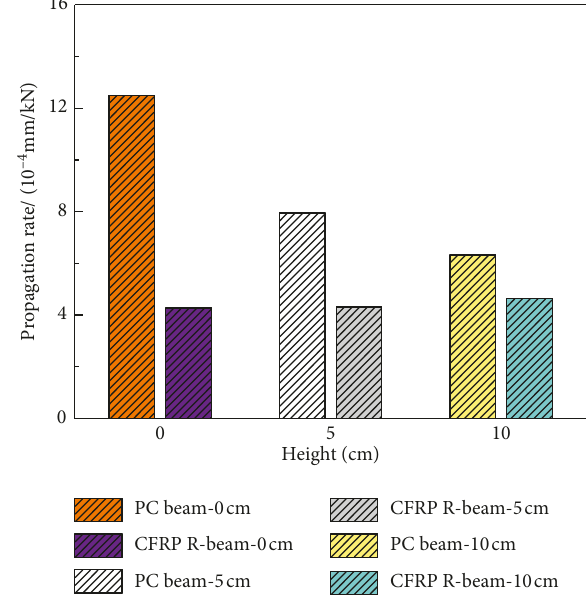
Figure 14: Cracking